Question: Identify the chart type used in this figure.
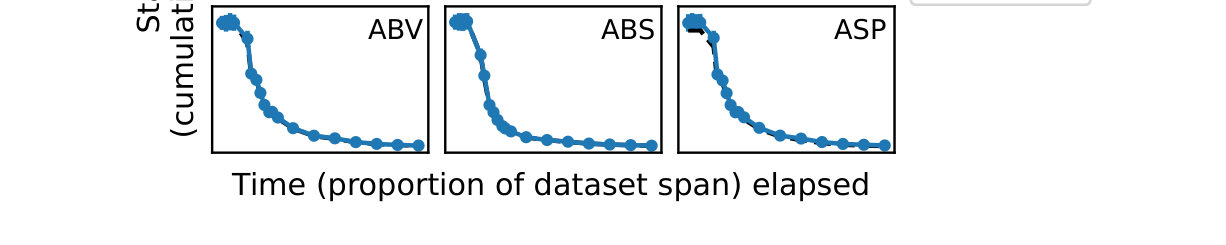
Answer: bar